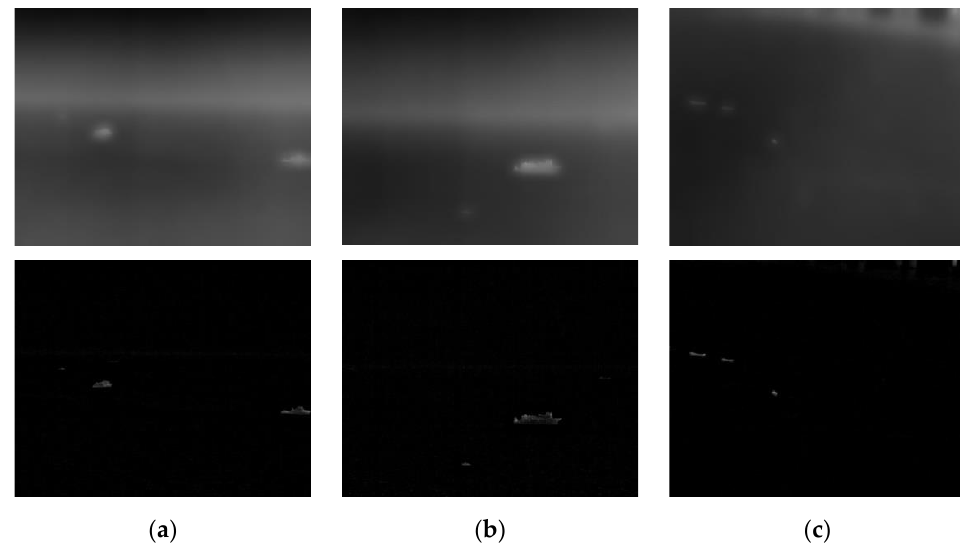
Figure 11. Target and background layers after guided filtering. The upper part of ( a – c ) is the background layer and the lower part is the target layer for each image.